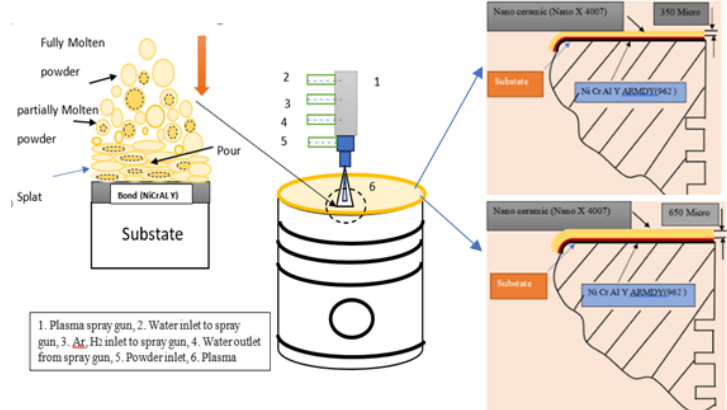
Figure 10: Schematic illustration of the creation mechanism of nanostructured coating with trimodal microstructure during plasma spraying of agglomerated nanostructured zirconia-based powders